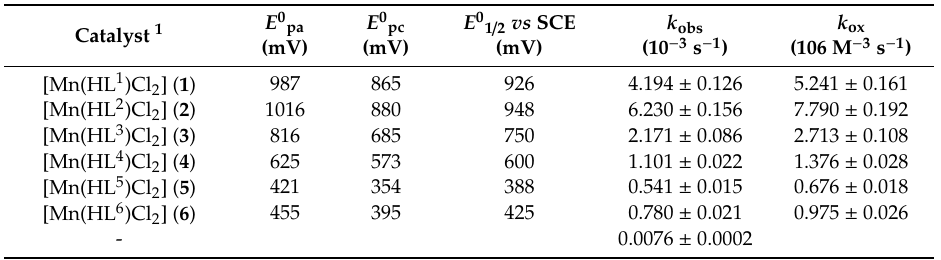
Table 4. Summary of kinetic data for the catalytic oxidation of morin with [Mn(HL 1–6 )Cl 2 ] ( 1 – 6 ) in bicarbonate bu ff er at pH 10 and 25 ◦ C.